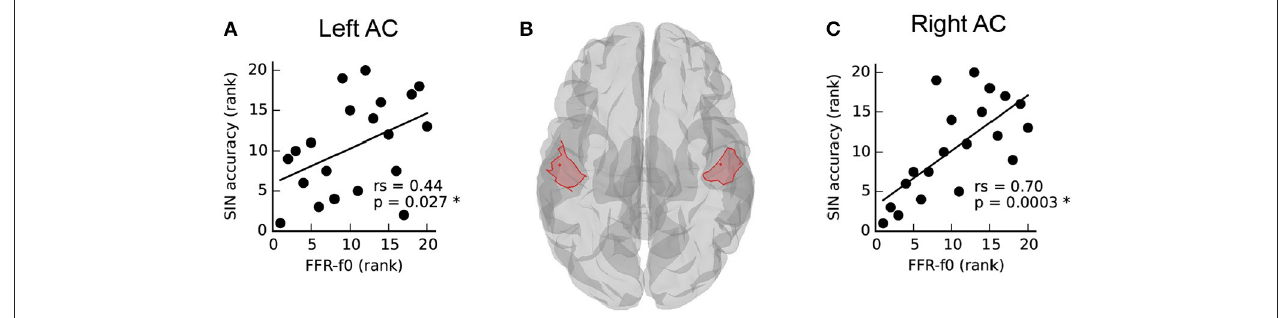
FIGURE 2 | Asymmetry in the relationship between speech-in-noise (SIN) and cortical FFR-f0 representation (A,C) within left and right hemisphere auditory cortex ROIs, illustrated in (B) . Although a positive relationship between FFR-f0 strength and SIN is found in each hemisphere, it is significantly stronger in the right hemisphere ( Z = − 3.12, p = 0.001,